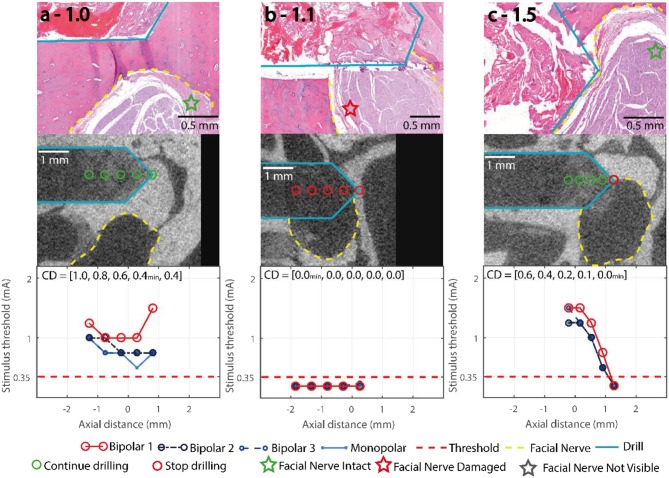
Representative trajectories of the training subject, stimulation thresholds of the FNM (bottom row), with the decision thresholds and the decisive electrode configuration marked in red, and electrode configurations Monopolar, Bipolar 2 and Bipolar 3 (blue). μCT (middle row), drill outlined in turquoise, measurement points marked red, facial nerve outlined in yellow. Histology (top row) with H&E staining, facial nerve assessment marked with a star. (a) 1.0: lateral distance > 0.4 mm, no warning from system. (b) 1.1: lateral distance < 0.0 mm, stimulus threshold below 0.35 mA indicates an emitted system warning at the first FNM point. (c) 1.5: frontal trajectory with final nerve distance < 0.1 mm, the system warned at the deepest FNM point.